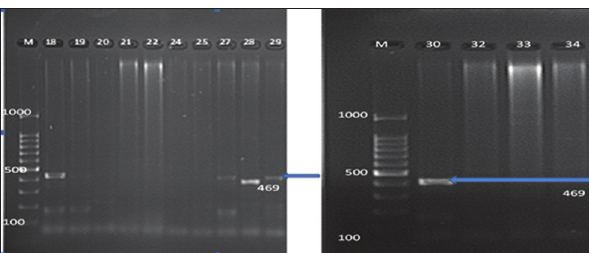
Figure-1: Amplification of qnrB gene by a polymerase chain reaction from Salmonella isolates. Ethidium bromide- stained agarose gel (75 V at 1 h). Lane M, DNA molecular size marker (100 bp ladder), lanes 18, 27, 28, 29, and 30 show positive results qnrB gene (469